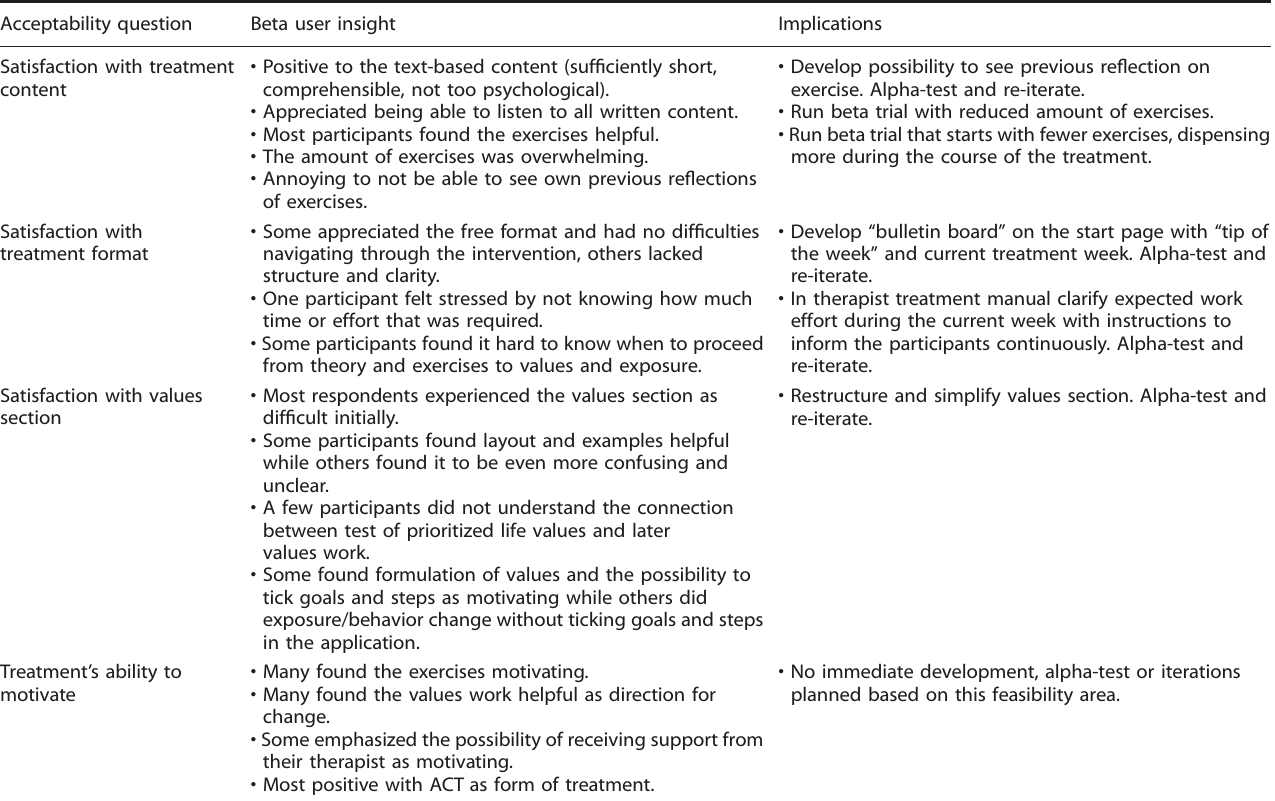
Table 1. Key patient end-user insights and implications from UX-interviews post beta testing. Acceptability